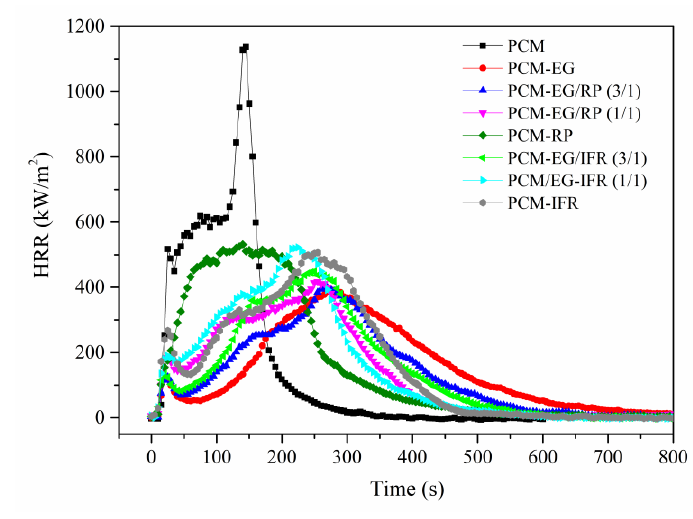
Figure 3. Heat release rates of SSPCMs. Table 3. Data from the cone calorimeter tests for SSPCMs (acrylic resin / flame retardant = 10 / 5).